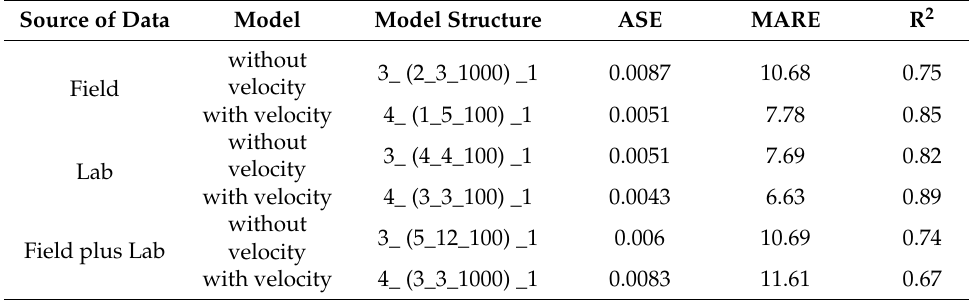
Table 5. Comparing ANN models (predicting water